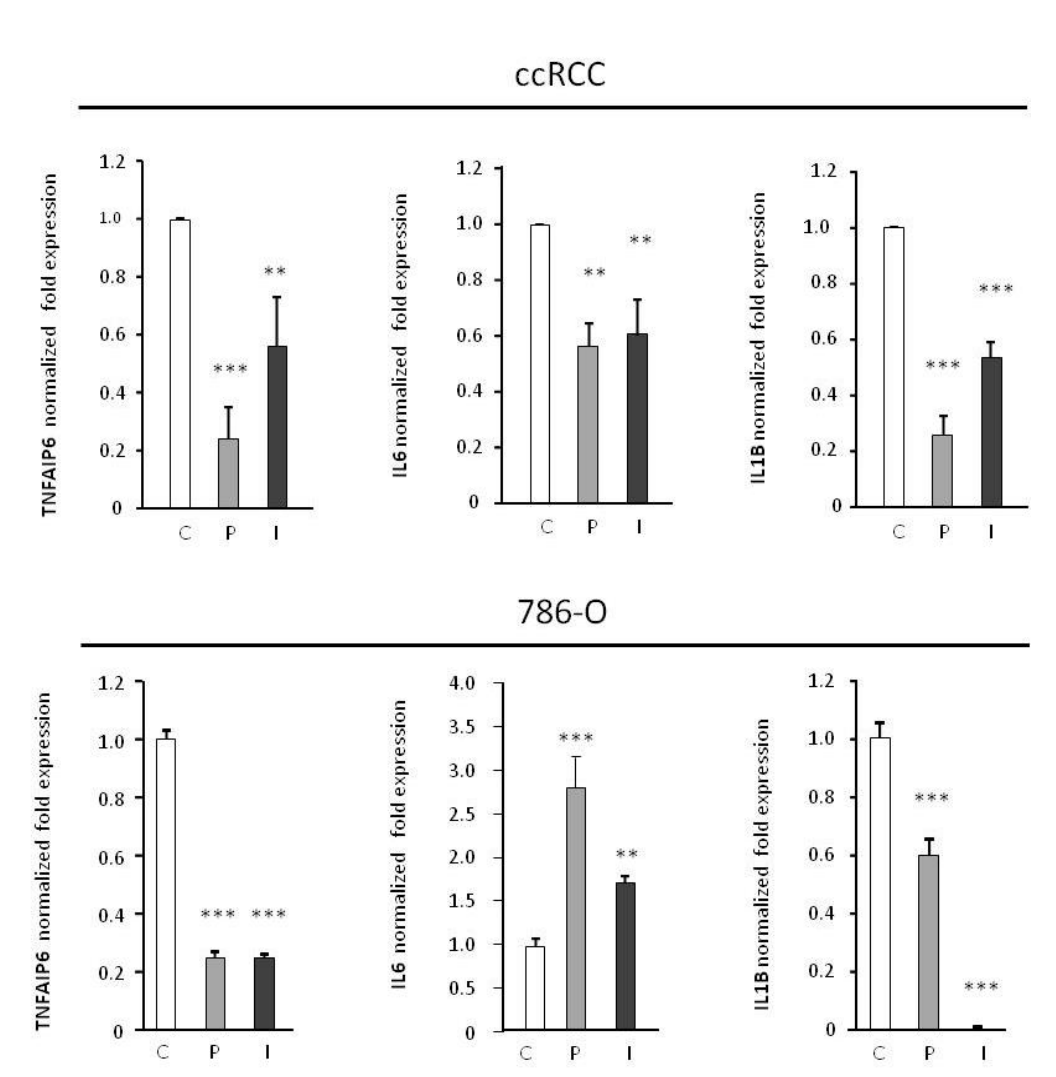
Figure 4. Effect of the β -blockers propranolol and ICI-118,551 on the mRNA expression levels of proinflammatory cytokines: TNFAIP6 , IL6, and IL1B , analyzed by RT-qPCR after treatment with [0 – 50 µM for 786-O and 0 – 100 µM for ccRCC] propranolol or ICI-118,551: ( A ) Average of the four primary VHL-ccRCC cultures analyzed. ( B ) On the 786-O line. To note: in oder to increase the amount of primary ccRCC cultures from the rare disease VHL and thus, to reinforce the pattern of dose response to ADBR blockers, we have included data from tumors ccRCC4 and 7, already published [2] . All data are based on three independent experiments. Error bars denote ± SEM. Student’s t -test: ** p < 0.01; *** p < 0.001. C: Control, P: propranolol and I: ICI-118,551.